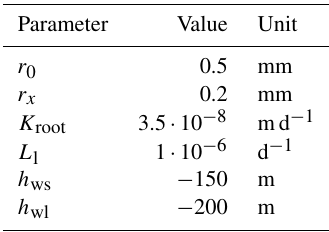
Table 2. Values of the parameters of the De Jong van Lier et al. (2013) model used in the simulations. h ws is the limiting value h w in Eq. (5) for the empirical models.